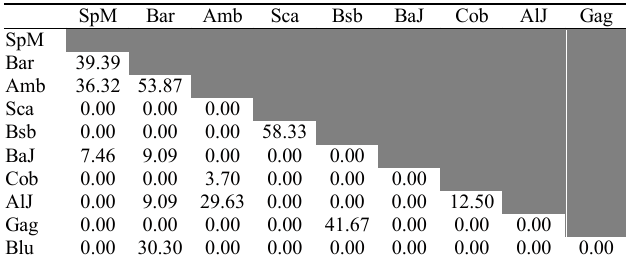
Table 2. Bray-Curtis similarity matrix based on species co- occurrences in mixed species foraging groups (n=17 mixed species groups of piscivorous fishes). Species codes as follows: AlJ=almaco jack Seriola rivoliana , Amb=greater amberjack Seriola dumerili , BaJ=bar jack Carangoides ruber , Bar=barracuda Sphyraena barracuda , Blu=blue runner Caranx crysos , Bsb=black sea bass Centropristis striata and bank sea bass Centropristis ocyurus , Cob=cobia Rachycentron canadum , Gag=gag grouper Mycteroperca microlepis , Sca=scamp grouper Mycteroperca phenax , and SpM=Spanish mackerel Scomberomorus maculatus